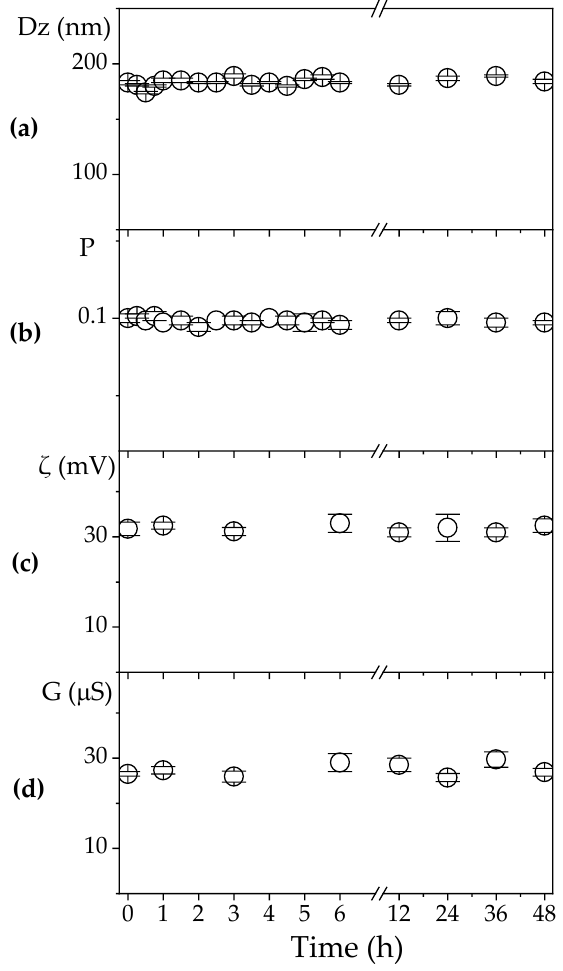
Figure 4. Effect of time on: ( a ) hydrodynamic diameter (Dz); ( b ) polydispersity (P); ( c ) zeta potential ( ζ ); ( d ) conductance (G) of PDDA / OVA NPs at [PDDA] = 0.01 mg · mL − 1 and [OVA] = 0.1 mg. mL − 1 .